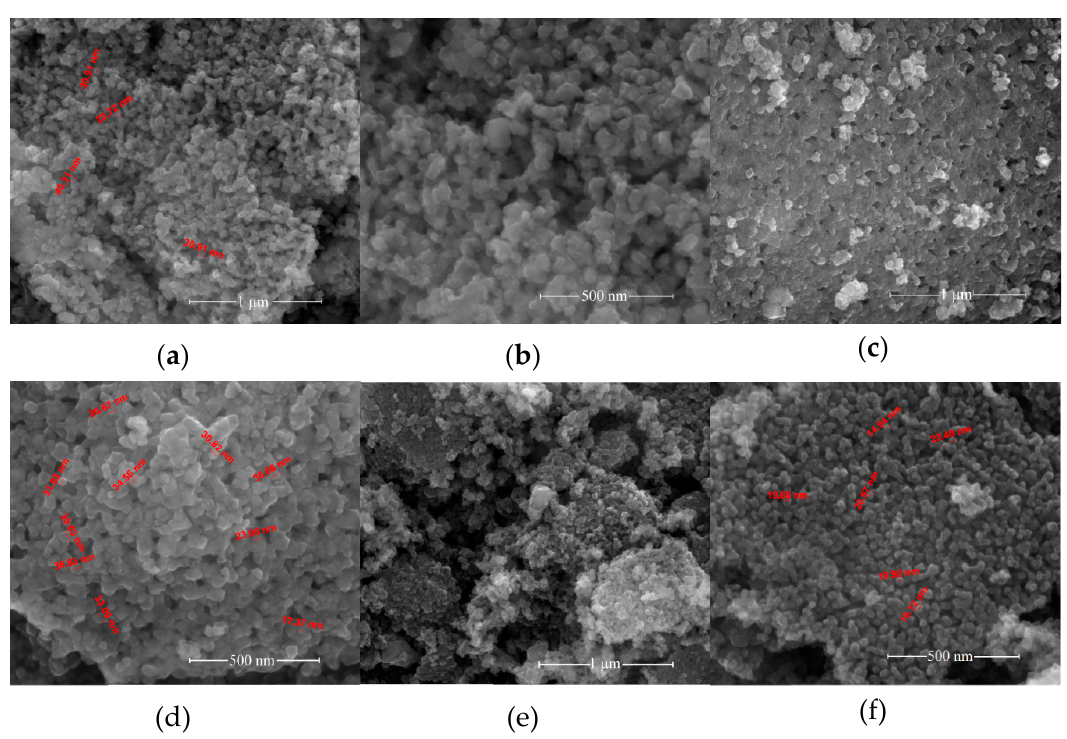
Figure 2. SEM micrographs at two magnifications of the BNT–BT 0.08 /CoFe 2 O 4 core–shell powders samples: ( a ), ( b ) S 1 ; ( c ), ( d ) S 2 and ( e ), ( f ) S 3